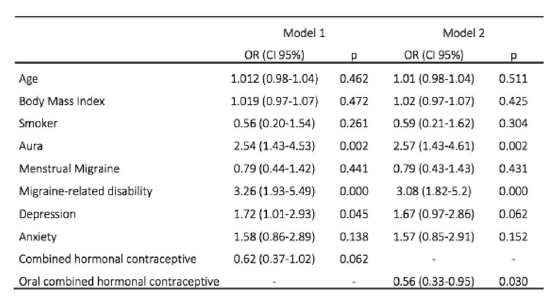
Table 2 (abstract P049). See text for description